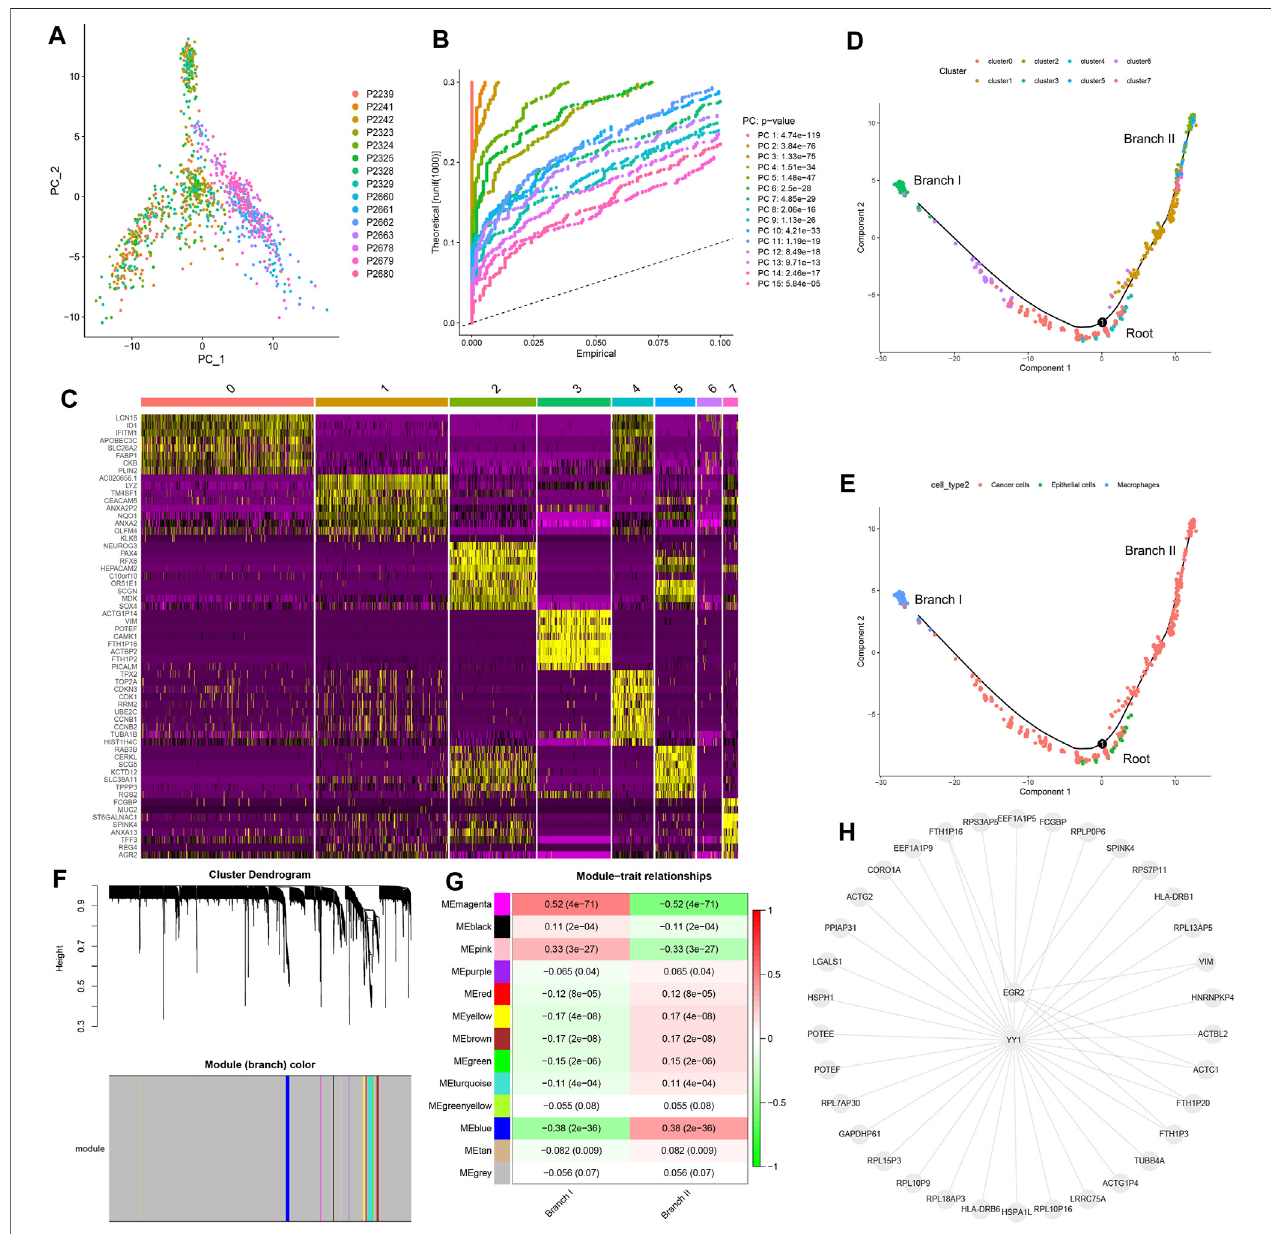
FIGURE 2 | Celltrajectoryanalysisand WGCNA. (A) PCA based onscRNA-seqdata. (B) The top 15 PCs. (C) Eight clusters wereidenti fi edbytSNEalgorithm, and a heatmapwasplottedtorepresentmarkergenes(top10%)ineachcluster. (D) Twosubsets(namely,branchIandbranchII)withdistinctdifferentiationstateswereidenti fi ed by cell trajectory analysis. (E) Cell types of subset I (branch I), subset II (branch II), and root. (F) Thirteen modules were identi fi ed using WGCNA. (G) Correlation analysis between modules and subsets. (H) Transcription factor enrichment analysis of key CDRGs. PCA, principal component analysis; PCs, principal components; tSNE, t-distributed stochastic neighbor embedding; CC, colon cancer; CDRG, CC differentiation-related gene. WGCNA, weighted correlation network analysis.